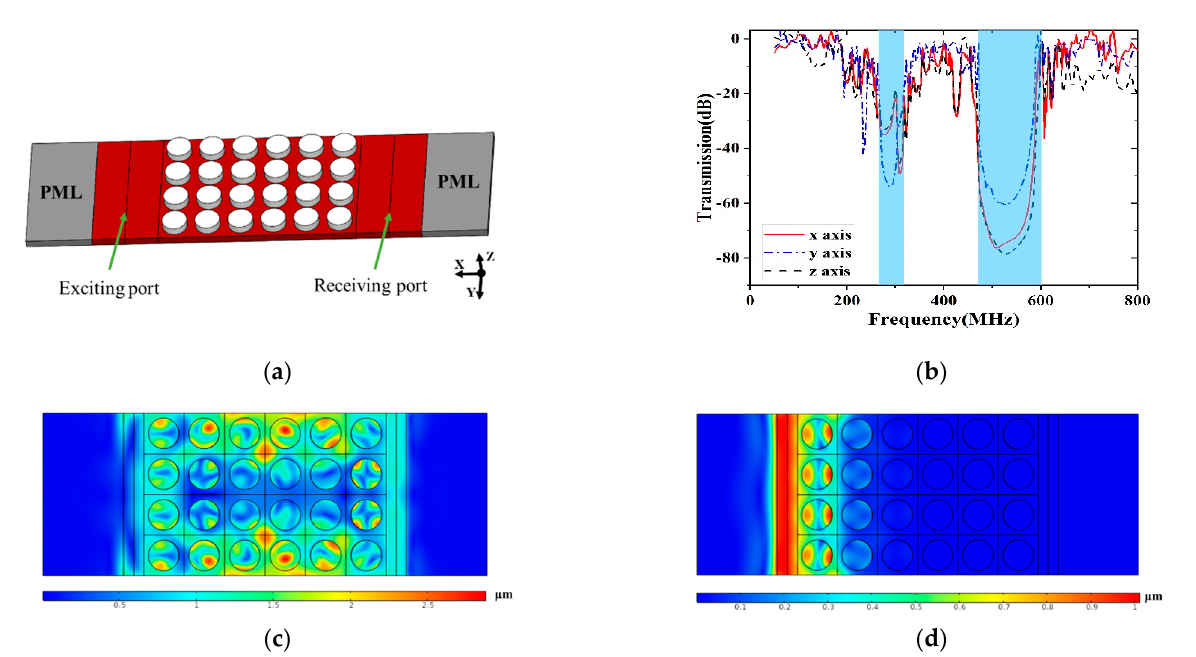
Figure 6. ( a ) Illustrations of the 4 × 6 pillar-based PnCs to analyze the transmission loss. ( b ) The simulated transmission spectra of acoustic wave via the PnC structure in x , y and z axes. ( c ) The displacement distribution at 700 MHz. ( d ) The displacement distribution at 550 MHz.